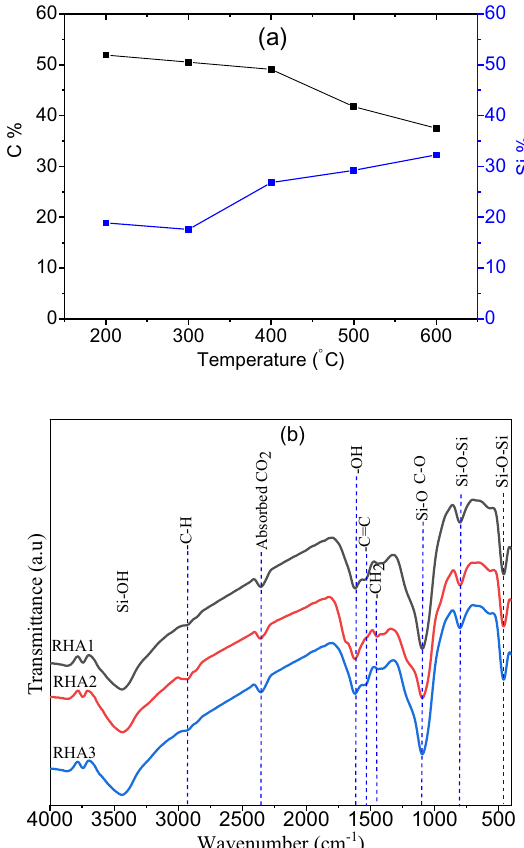
Figure 2. ( a ) Variation the percentage of C and Si with temperature, and ( b ) FTIR of RHA1, RHA2, and